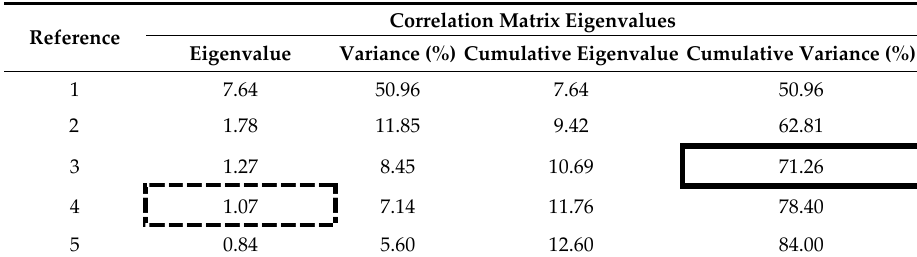
Table 7. Principal components’ eigenvalues and variances.